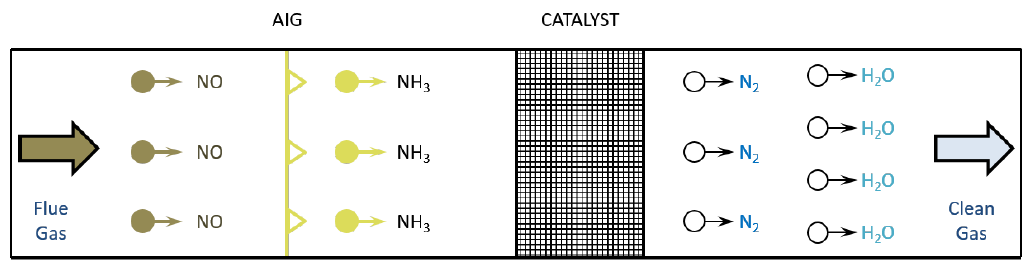
Figure 1. Concept of selective catalytic reduction (SCR) denitrification process in the thermoelectric power plant.